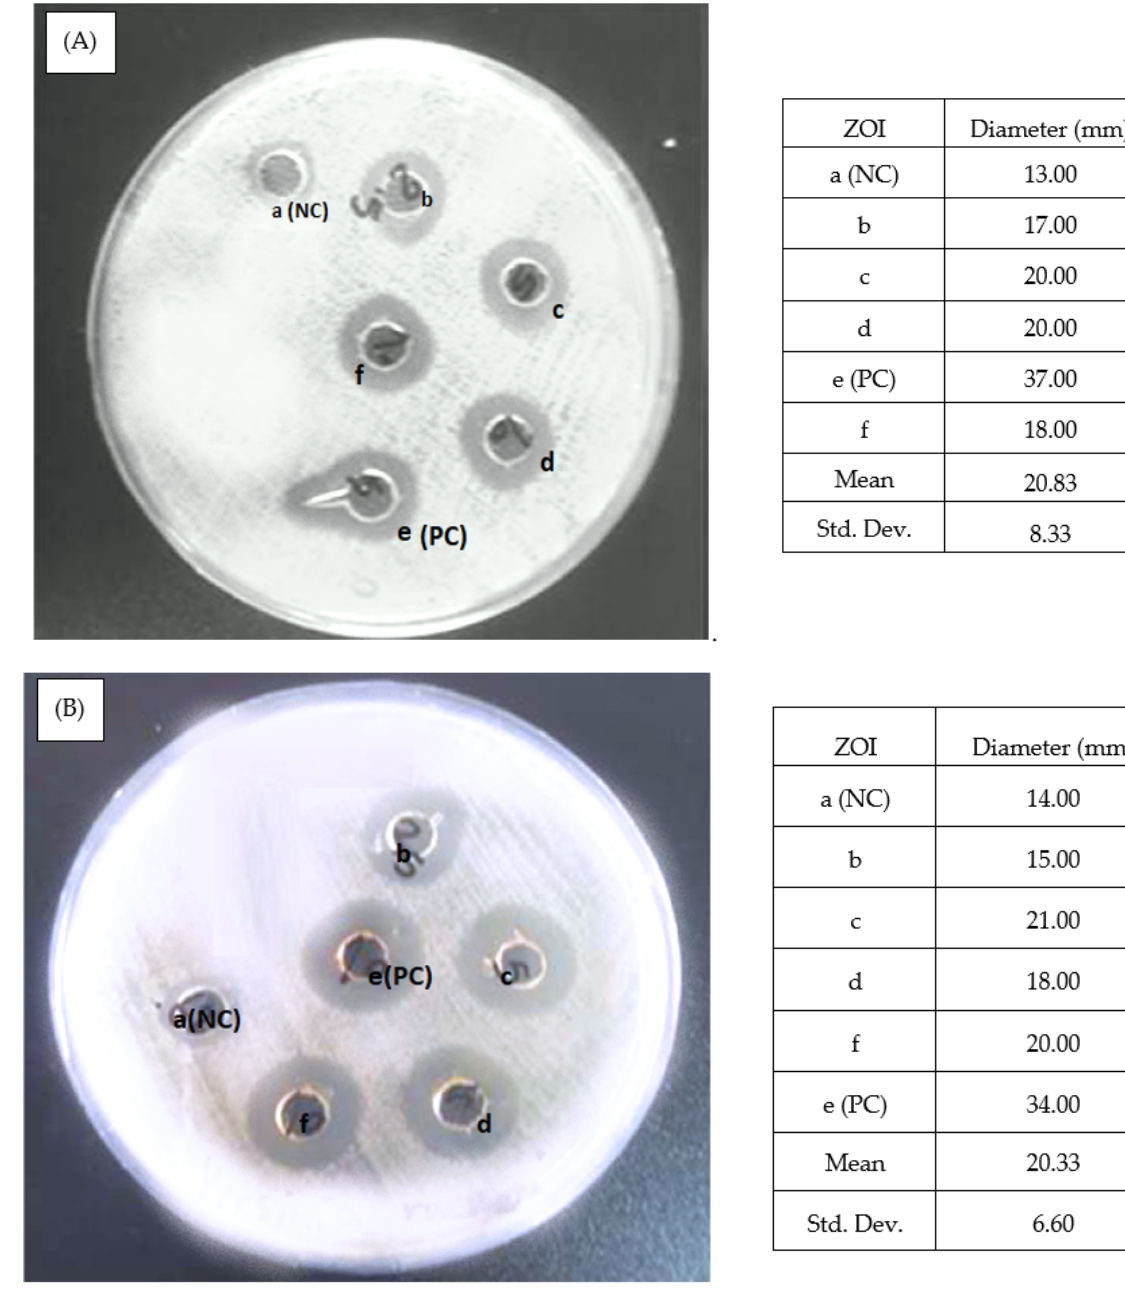
Figure 7. DPPH free radical scavenging assay for AC-AgNPs was related to the standard. Measure- ments were completed in triplicate (n = 3, mean ± SD) in a bar chart.